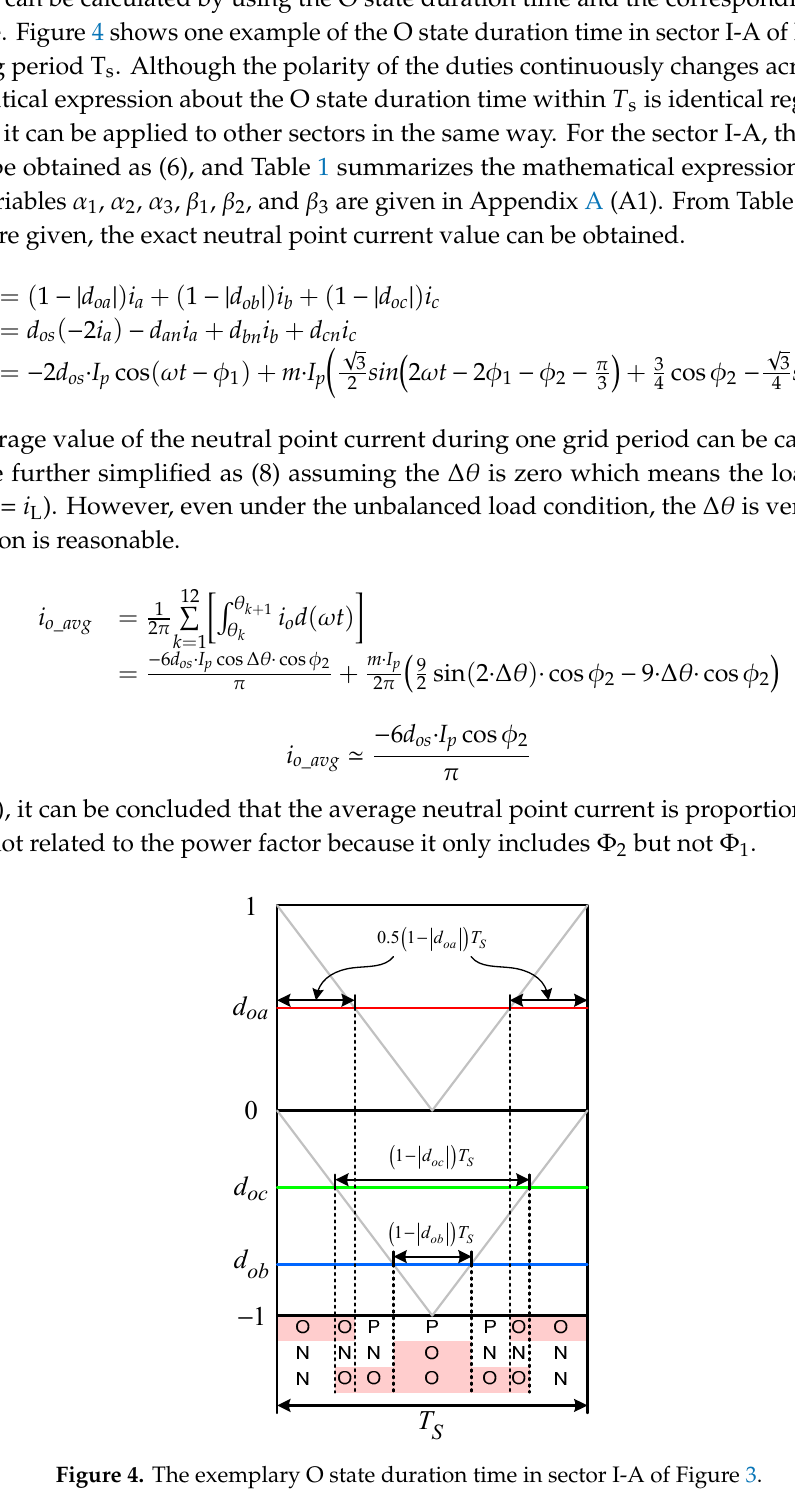
Figure 4. The exemplary O state duration time in sector I-A of Figure 3.